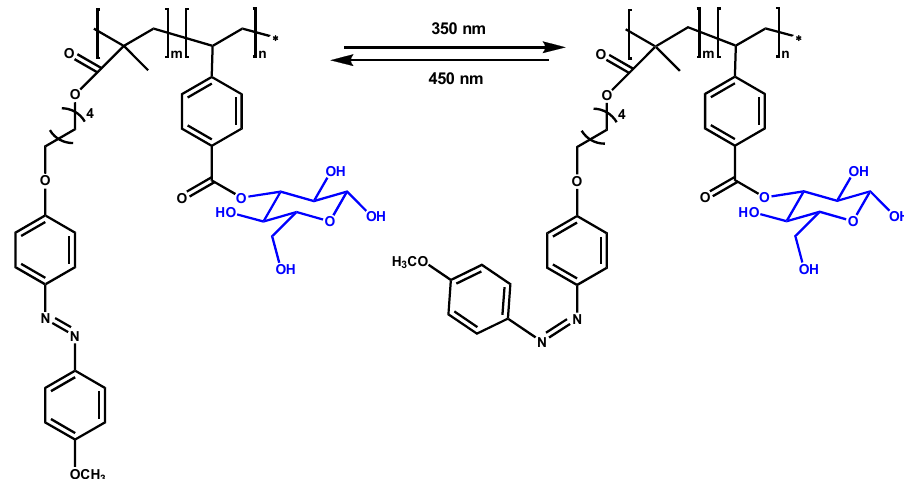
Figure 6. Light-induced isomerization of block copolymers poly(azobenzene methacrylate)- b -poly(3-O-4-vinylbenzoyl-D-glucopyranose), under alternate ultraviolet and visible irradiation for encapsulate-release